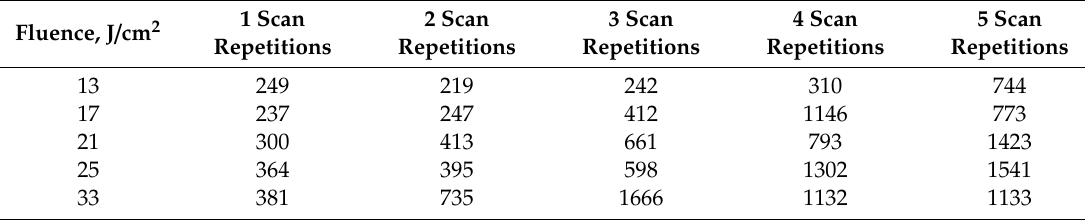
Table 3. R a roughness parameter for laser-treated areas, nm.